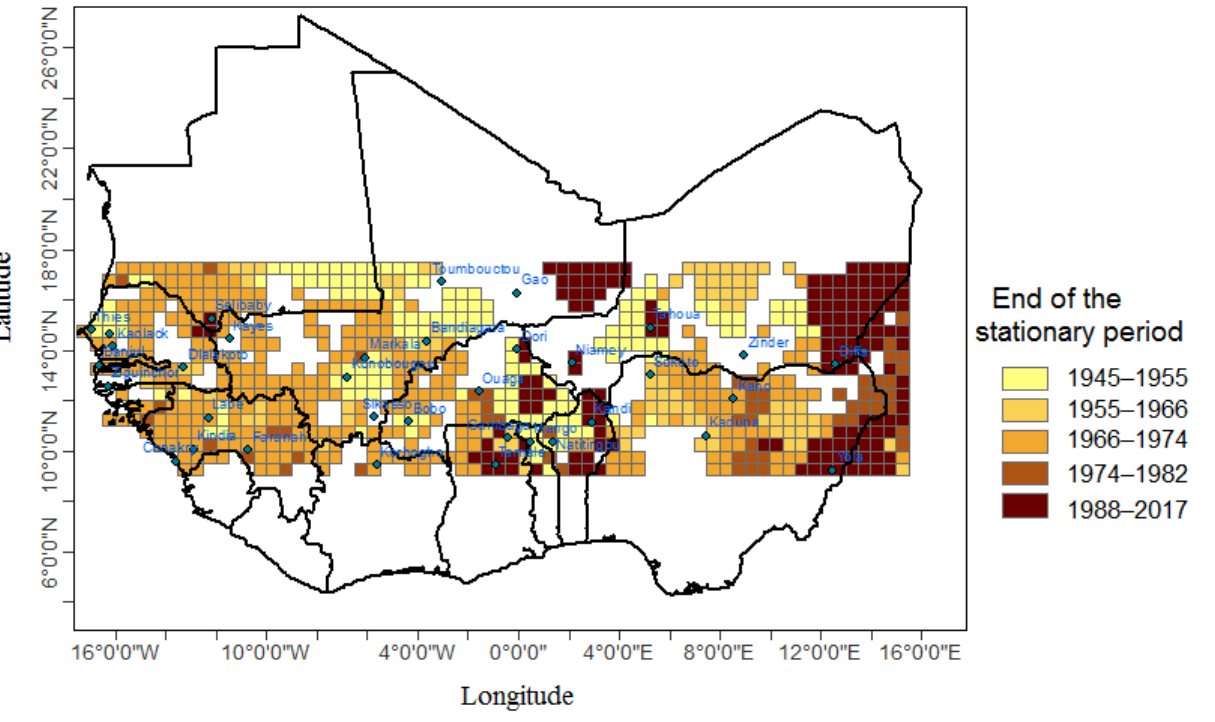
Figure 9. End of the stationary segments (beginning in 1901) with